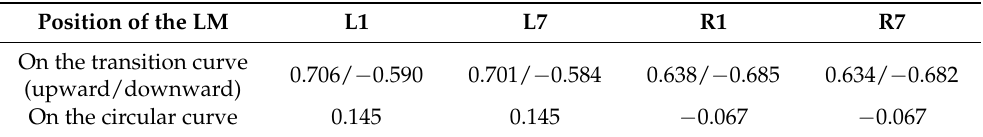
Table 2. Maximum Deflection deformation amplitudes of the LMs on the 650 m radius curve (unit: mm, V = 93 km/h).